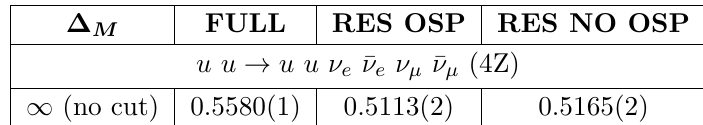
Table 4 . Cross sections ( ab ) for u u u u (cid:23) e (cid:22) (cid:23) e (cid:23) (cid:22) (cid:22) (cid:23) (cid:22) . All diagrams are taken into account for the full ! calculation (FULL), while only double resonant diagrams contribute to the two rightmost columns, with (RES OSP) and without (RES NO OSP) projection. Selection cuts are: p j 5 : 5 ; M jj > 600 GeV ; (cid:1) (cid:17) jj > 3 : 6 ; M 4 ‘ > 300 GeV. j j